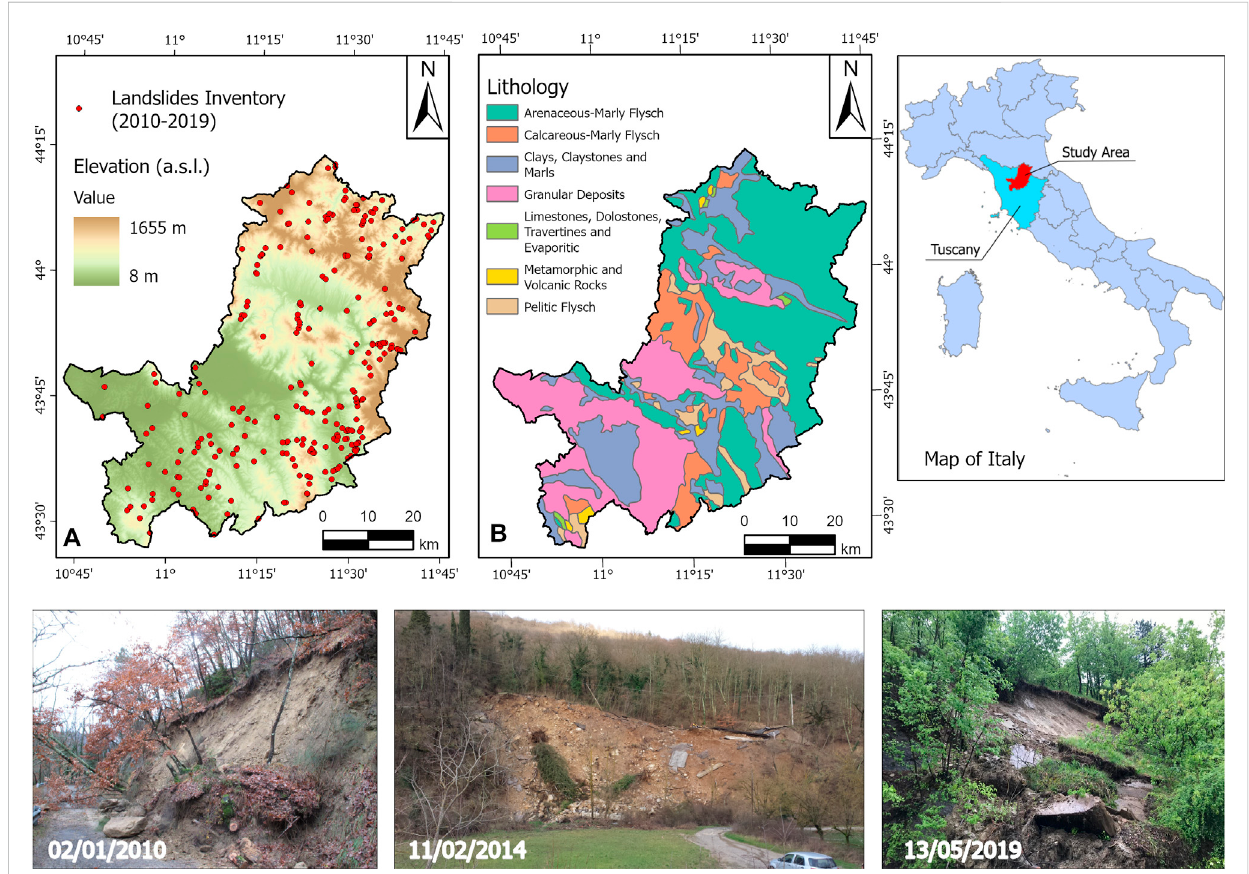
FIGURE 1 (A) elevation map of the MCF with the landslides inventory overlapped; (B) lithological map; three images of example of landslide events from the inventory used, triggered in January 2010, February 2014 and May